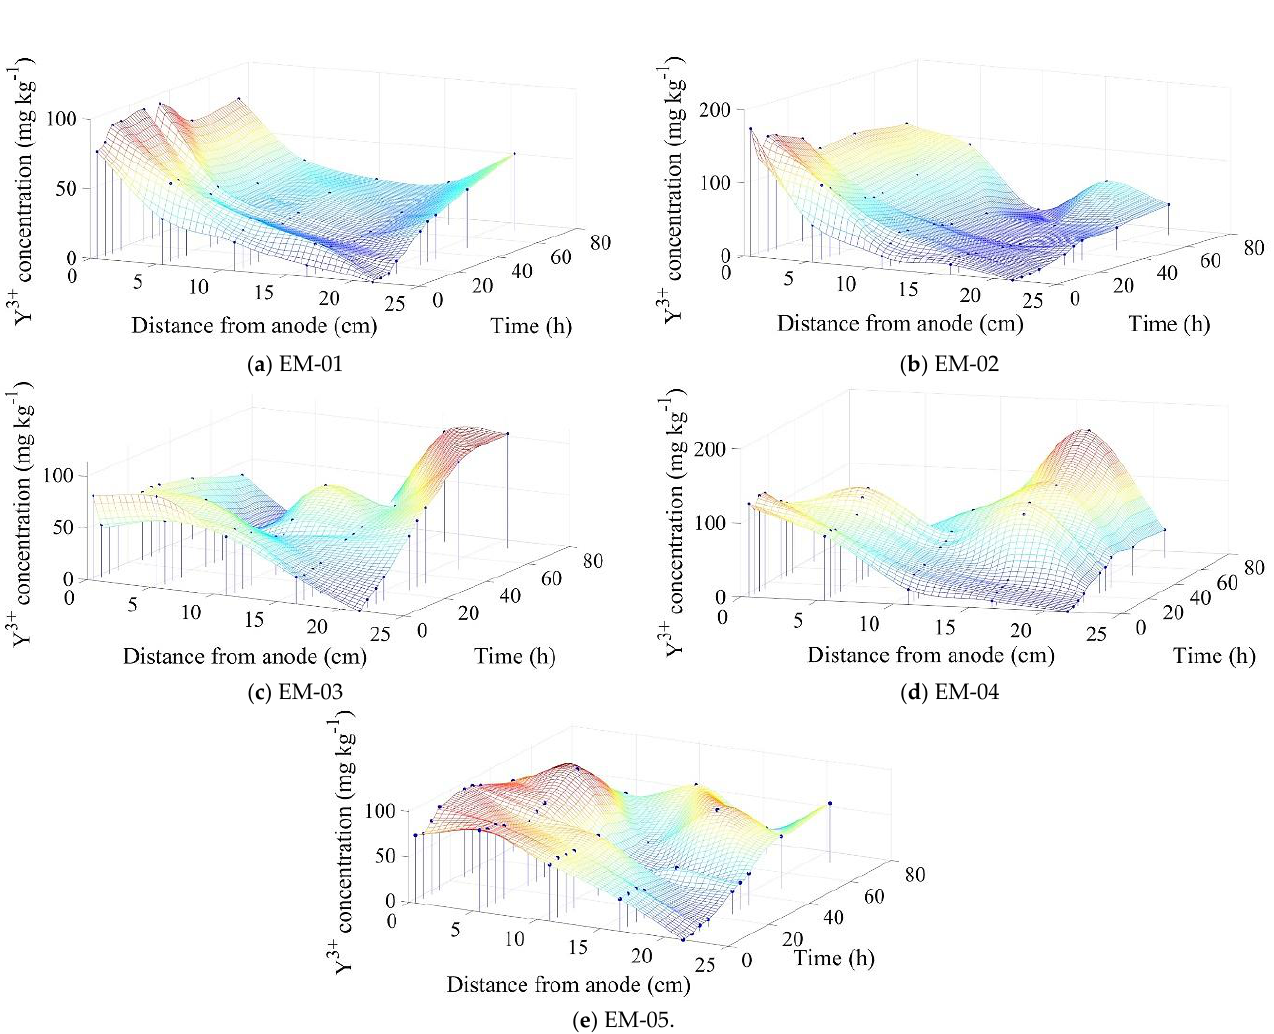
Table 3. EMS analysis parameters.